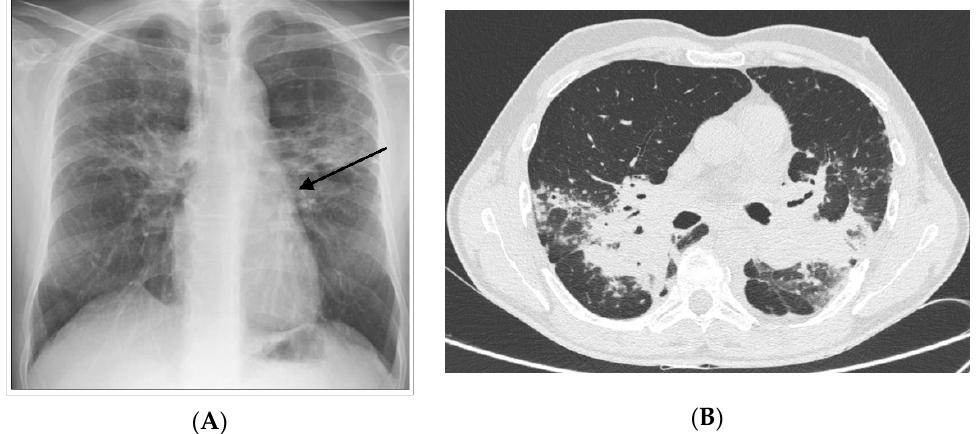
Figure 2. Chronic form of sarcoidosis. ( A ) Posterior-anterior chest radiograph of a 55-year-old man with progressive pulmonary fibrosis despite treatment demonstrating permanent, coarse linear opacities, radiating laterally from the hilum upward and outward (arrows). ( B ) high-resolution CT showing intra parenchymal enlargement of pulmonary arteries and enlarged pulmonary trunk at the bifurcation.